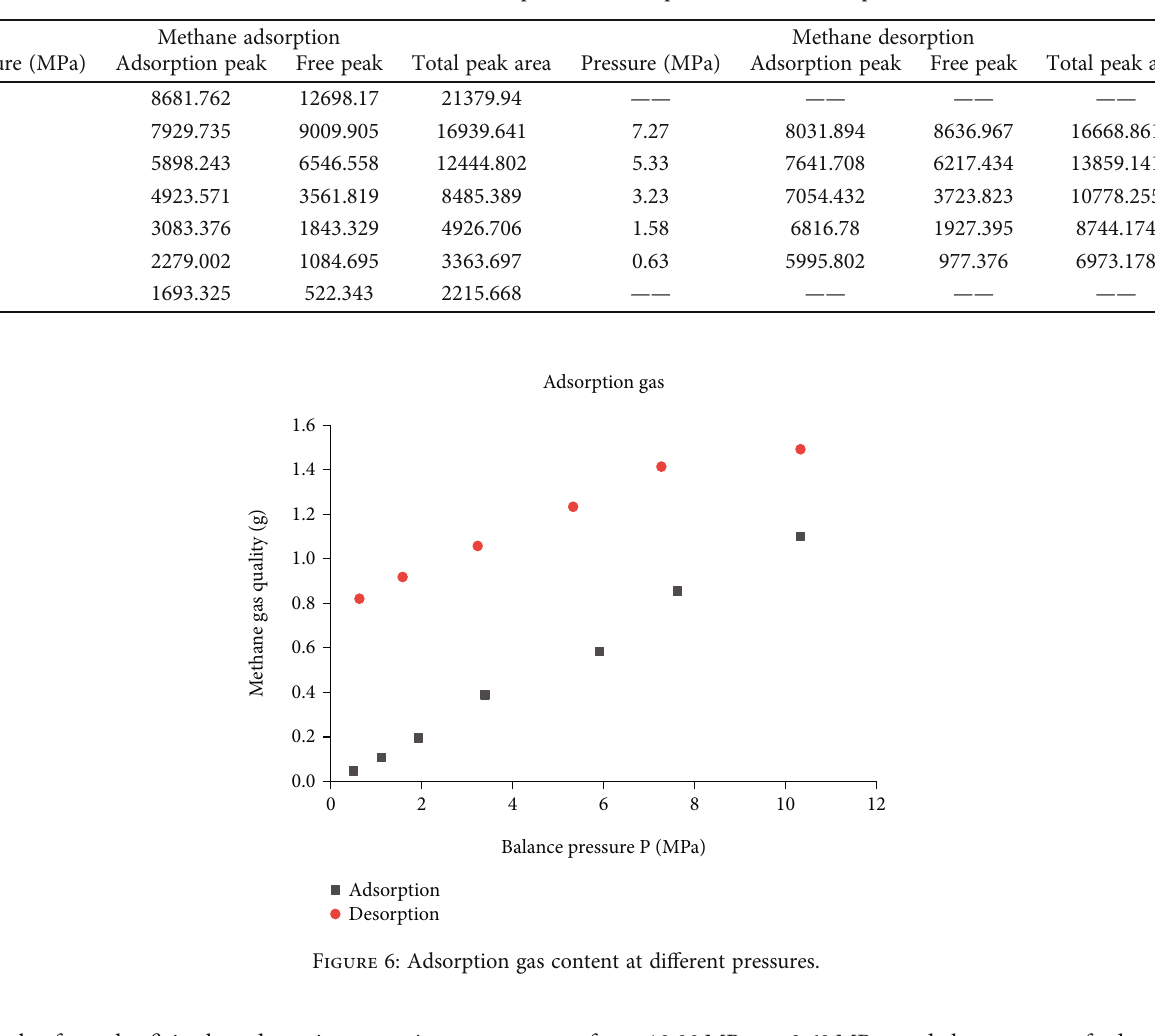
Table 3: Peak area of methane adsorption and desorption under di ff erent pressures.